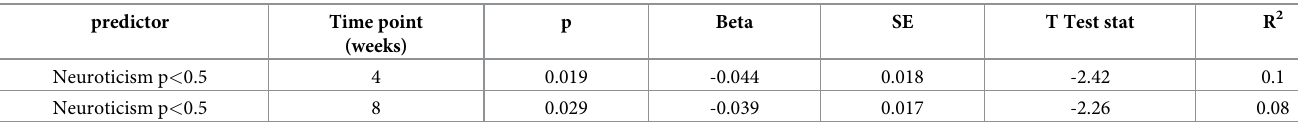
Table 2. Nominally significant individual PRS models (AMSP-2 cohort).